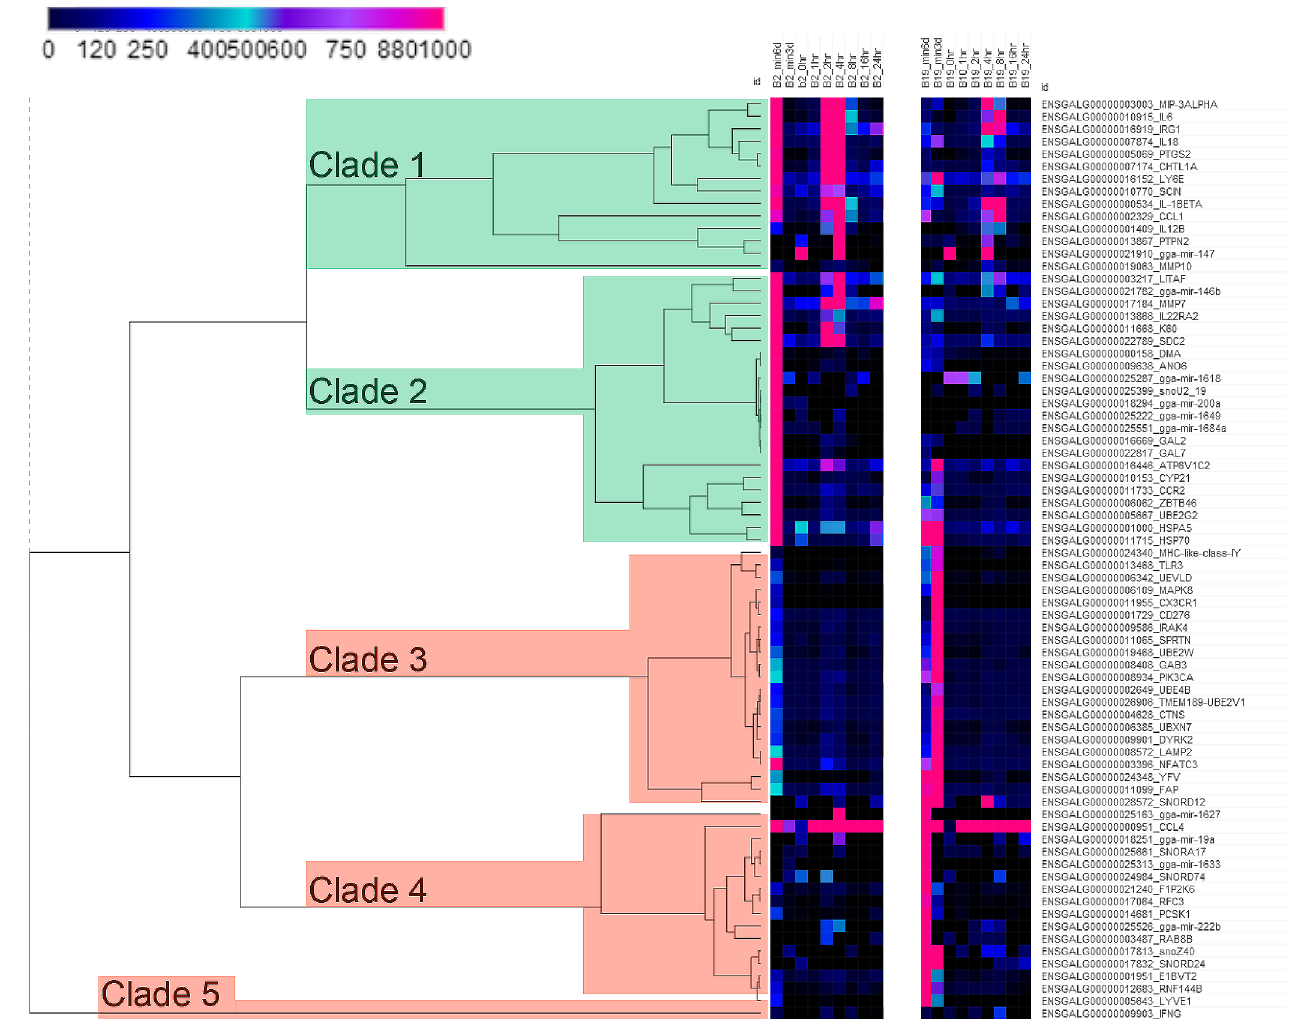
Fig 6. Identification of divergent gene expression patterns between B2 and B19 macrophages. Visualizationof divergentgene expression patterns betweenthe B2 and B19 haplotypes. A subset of genesexhibitingdivergent gene expressionwere identified and visualizedin heat followinghierarchical clusteringof the genes (rows), but not the time points (columns). The genes cluster into four major clades (clade1, clade2, clade3,and clade4) with a singletongene (labelledclade 5). Among these genes, representedin clade1 and clade2, are a number of miRNAs exhibiting strong expressionin B2 cells (mir-147, mir-146b, mir-1618, mir-200a, mir-1649, and mir-1648a) comparedto the B19 samples. Likewise, miRNAs containedin clade3 and clade4exhibit greater expressionin B19 cells (mir-1627,mir-222b, mir-1633, and mir-19a). Additionally,a number of small nucleolar RNAs (snoRNAs) exhibit similarlydichotomous gene expression patterns (clade4)such that SNORd24,snoZ40, SNORD74, SNORA17, and SNORD12 exhibitsubstantially higherlevels of expressionin B19 cells on day -6 compared to B2 cells whileB2 cells express such as